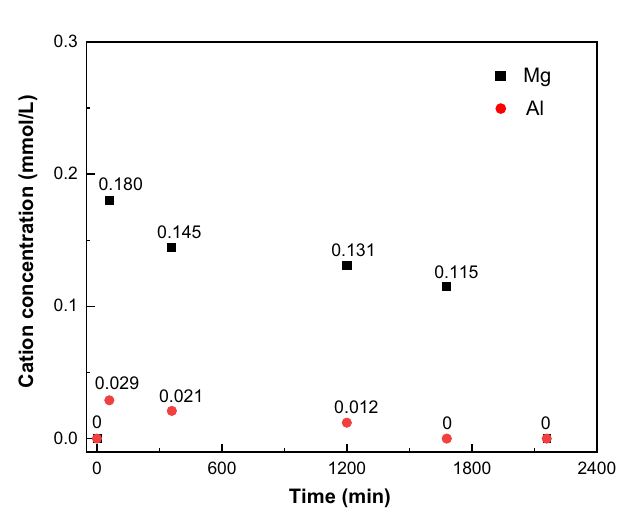
numbers. b Overlay of in situ 1 H MAS NMR spectra in ( a ) in the range of 0 − 4.5ppm with t = 10 − 60 min along with the corresponding spectral assign- ments. c Overlay of in situ 1 H MAS NMR spectra in ( a ) in the range of 4 − 7 ppm with t = 10 − 60min. d Overlay of in situ 1 H MAS NMR spectra in ( a ) in the range of 4 − 7 ppm with t = 1 − 8h.